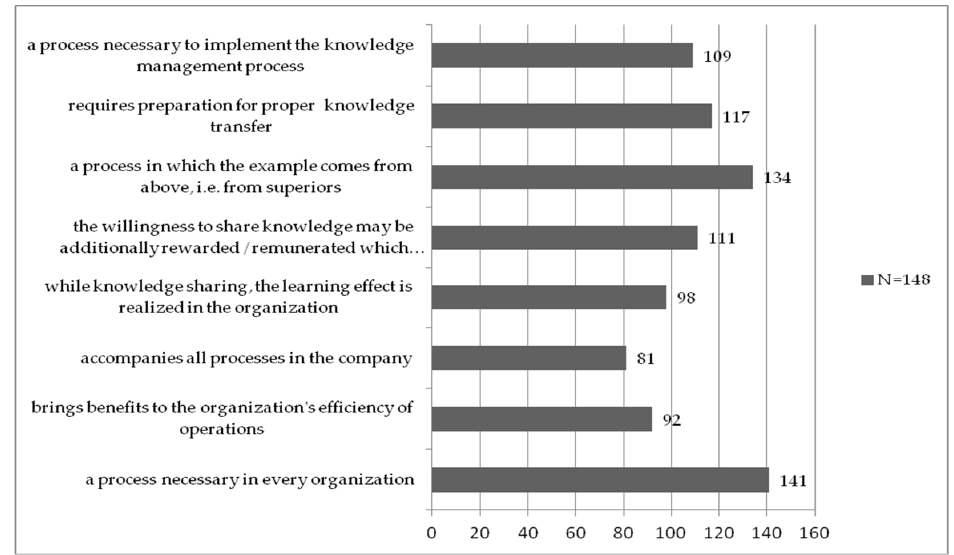
Figure 3. Knowledge sharing according to respondents. * respondents had the opportunity to indicate several statements.